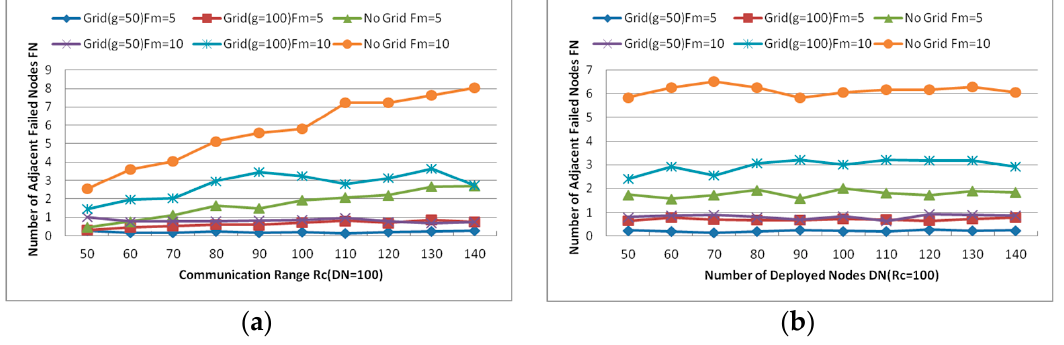
Figure 14. ( a ) Parameter values with different Fm; and ( b ) FN with different Fm.